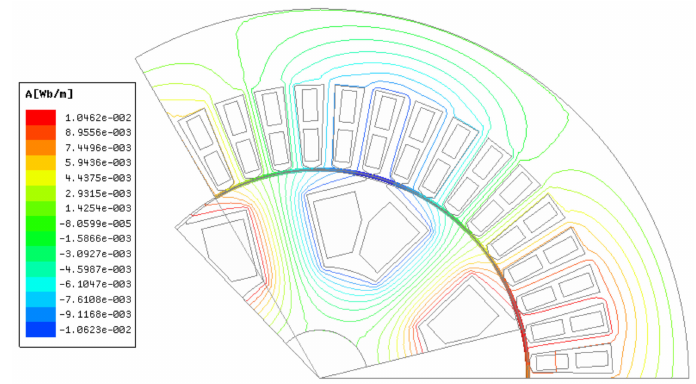
Figure 11. Distribution of magnetic-field lines of the generator.